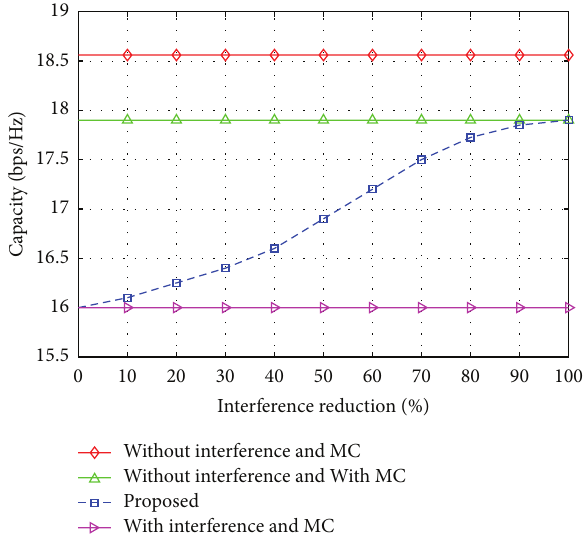
Figure 9: Relation between channel capacity and interference re- duction for SNR = 20 dB.